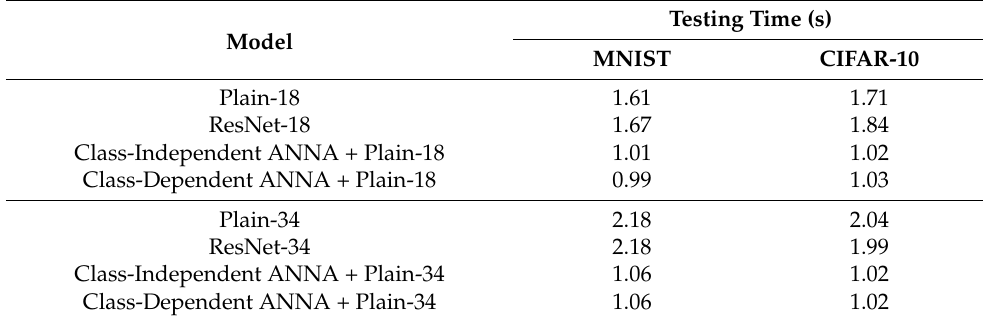
Table 5. Testing time on MNIST dataset and CIFAR-10